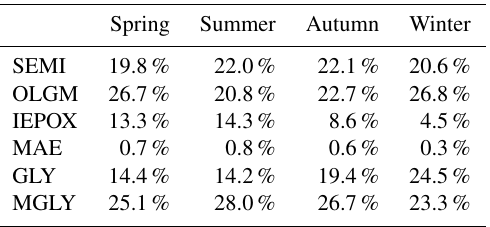
Table 2. Predicted seasonal average component contributions